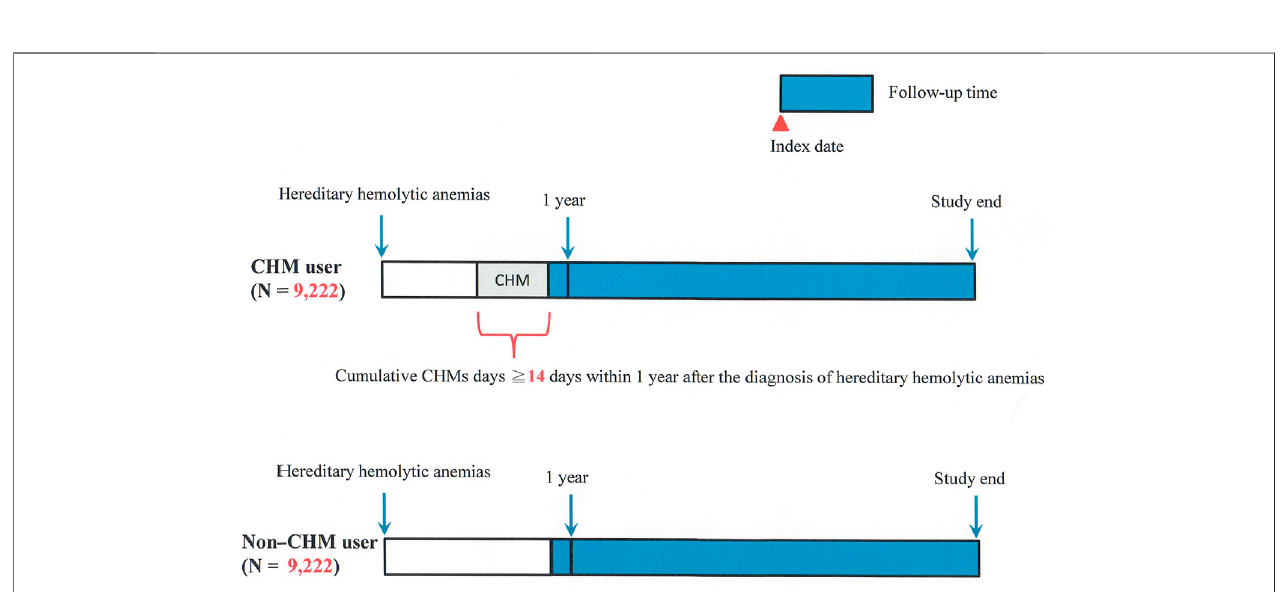
FIGURE 2 | Diagram of follow-up time for patients with HHAs. Abbreviations: HHAs, hereditary hemolytic anemias.